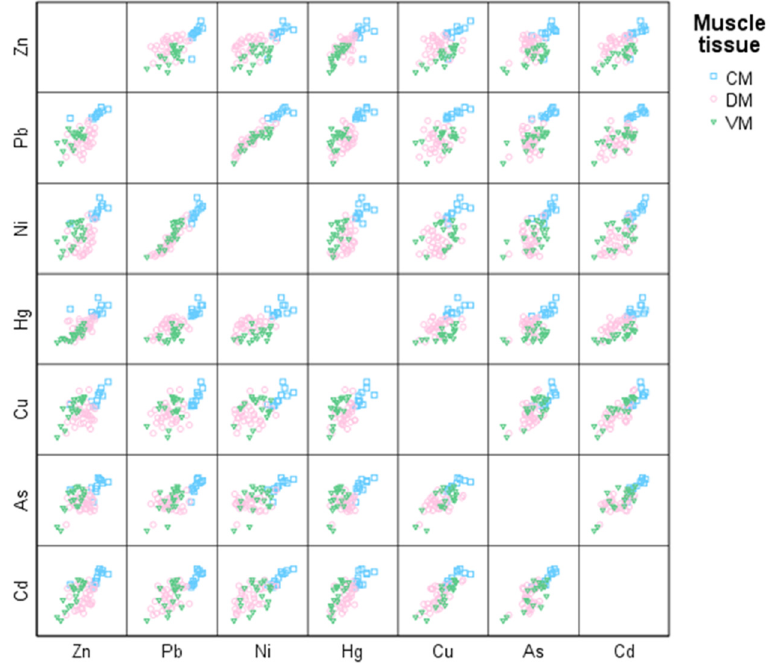
Figure 3. Pearson correlation matrix for the different metals analyzed subdivided into muscle groups.